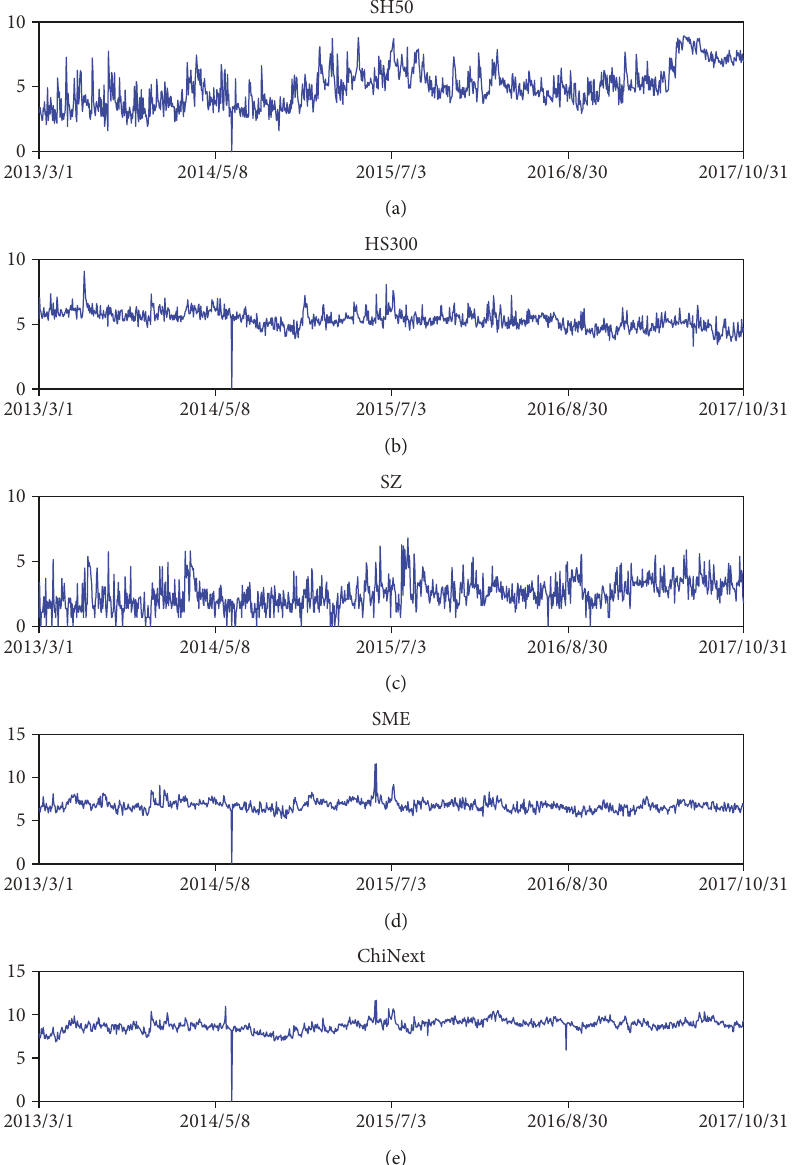
Figure 1: The evolution of Weibo attention. This fi gure shows the evolution of Weibo Index of di ff erent stock markets from March 1, 2013 to October 31, 2017. We notice that there are some zero values in the fi gure. After checking the data, we found that zeros fall into the nontrading days. In the following empirical analysis, these calendar days are removed from the